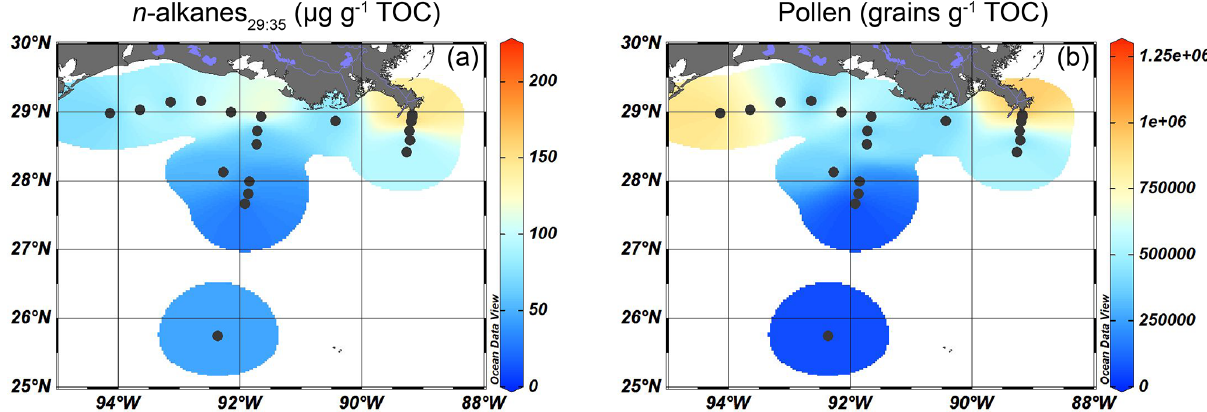
Figure 7. Isosurface plots for the input of higher plant-derived OM in surface sediments of the GoM based on OC-normalized concentrations